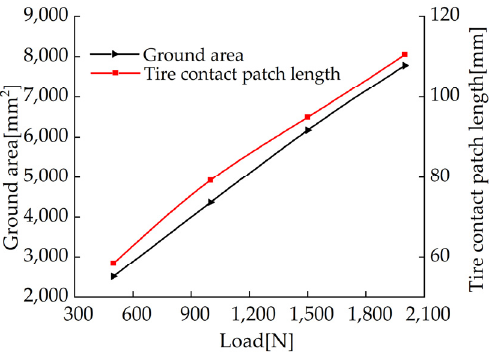
Figure 14. Curves of tire contact area and longitudinal contact length under different loads.